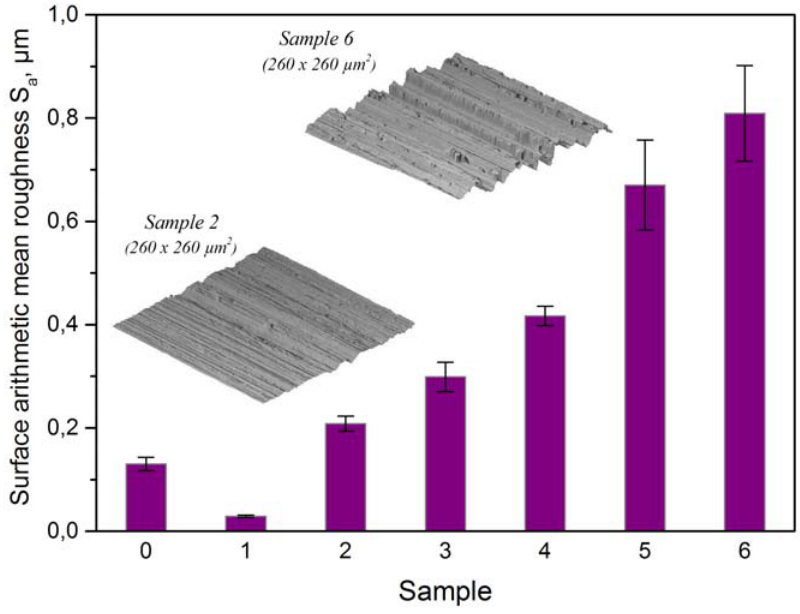
Figure 3. Surface arithmetic mean roughness (DIN EN ISO 25178) [9]. Error bars are the standard deviations.